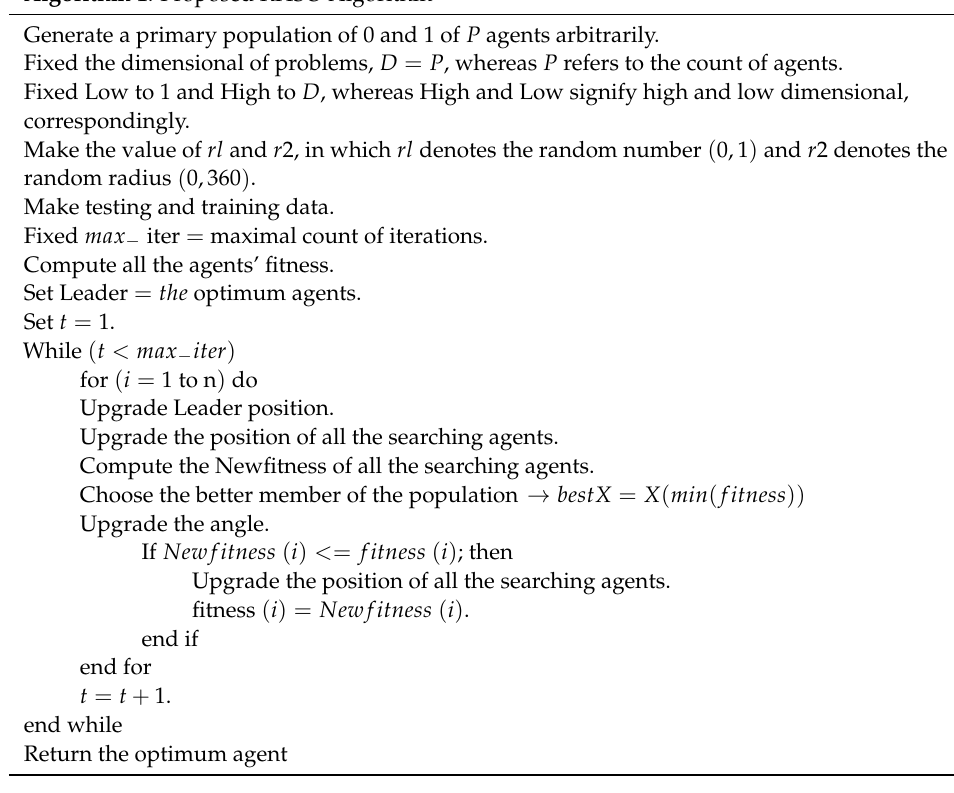
Algorithm 1 : Proposed RHSO